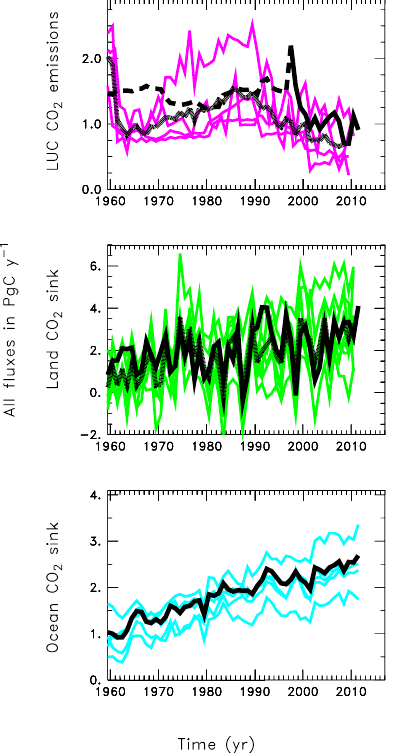
Figure 5. Comparison of (top panel) CO 2 emissions from land-use change (LUC), (middle panel) land CO 2 sink ( S LAND ), and (bottom panel) ocean CO 2 sink ( S OCEAN ) between the CO 2 budget values es- timated here (black line), and those estimated from process models without any normalisation to observations (Table 3; coloured lines). The thin dotted black lines in the top and middle panels are the model averages. The LUC emissions from the CO 2 budget estimate is dashed before year 1997 to highlight the start of the satellite data from that year, as used to quantify the interannual variability from management–climate interactions based on fire activities in defor- ested areas.